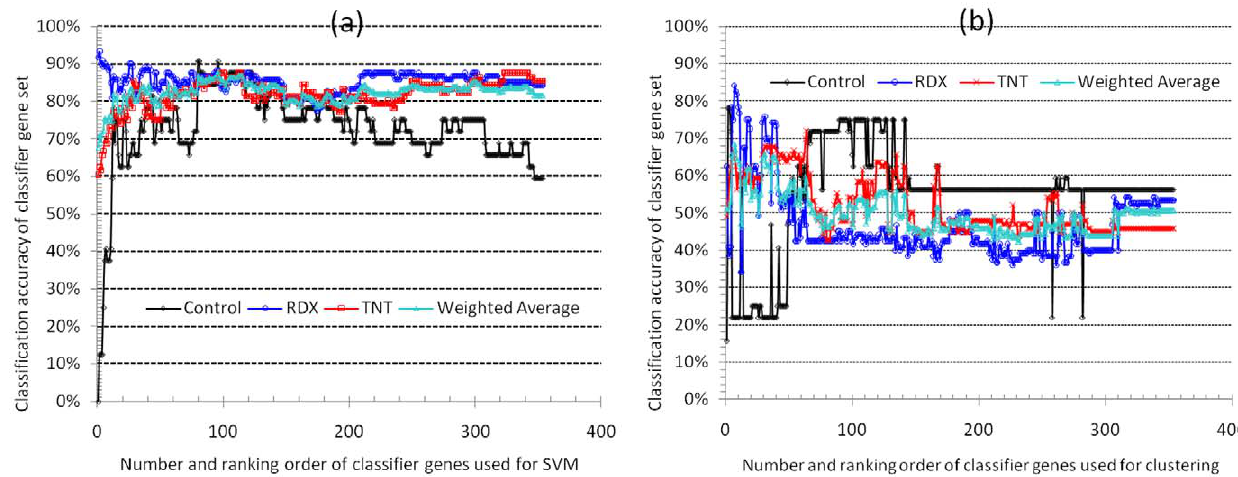
Figure 4. Classification accuracy of 248 earthworm samples using SVM (a) or clustering (b) with an increasing number of top ranked classifier genes. The weighted average accuracy and the accuracy for each of the three classes (control, RDX and TNT) are shown for each set of genes (1 , 354 genes). Genes were added to the increasing gene set one at a time in the order of decreasing overall weight (see also Figure 3 (a)).